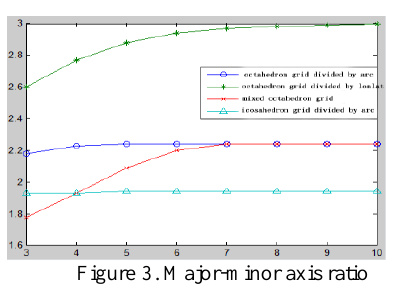
Figure 2. Mean square deviation of max/min area ratio